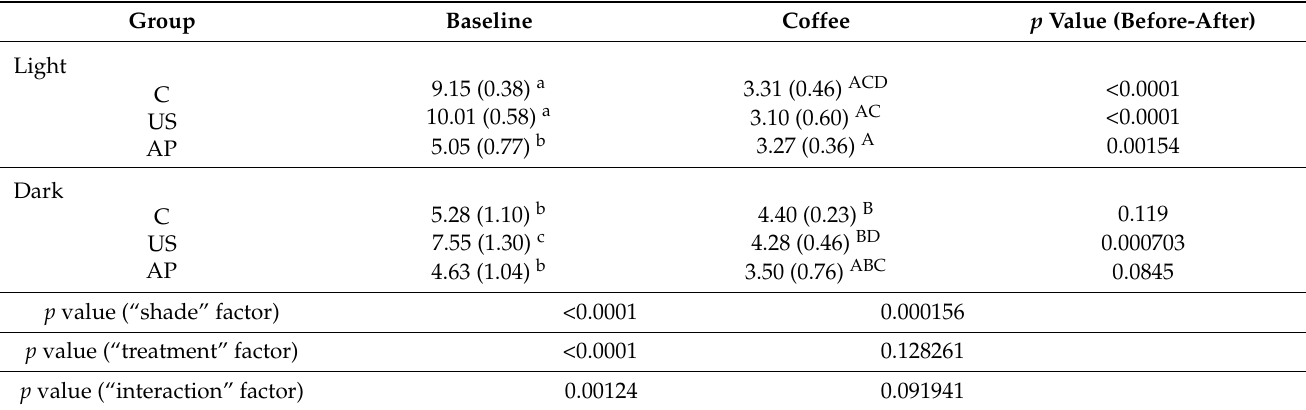
Table 2. Mean translucency (TP) values (standard deviation) of the tested specimens at baseline and after immersion in coffee